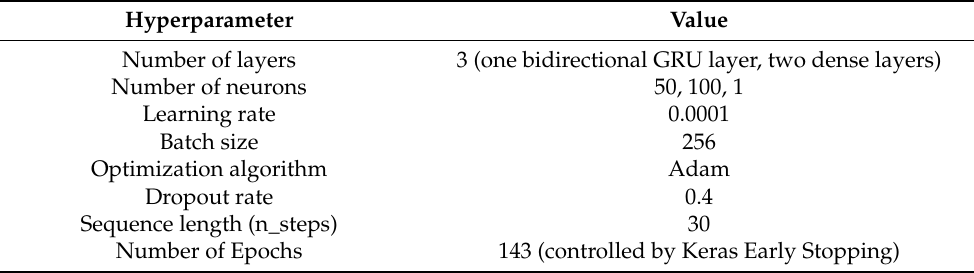
Table 6. Final GRU model’s